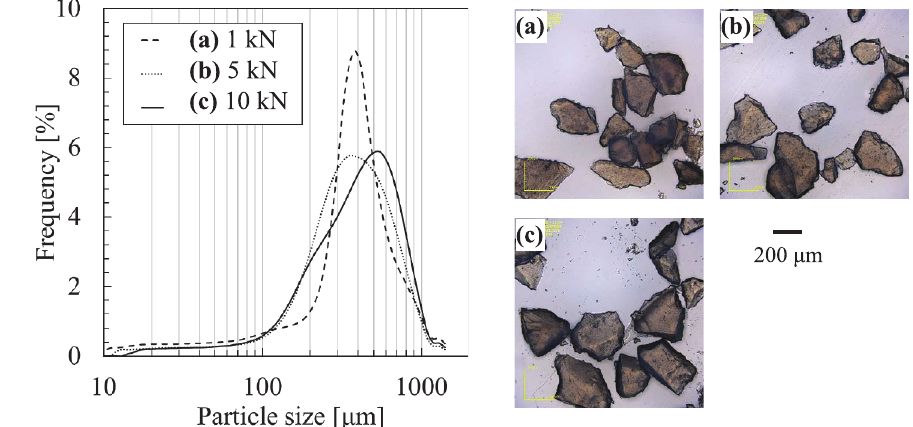
Fig. 7 Particle size distributions (left) and optical microscopic observations (right) of the model aggregates prepared with (a) 1 kN, (b) 5 kN, and (c) 10